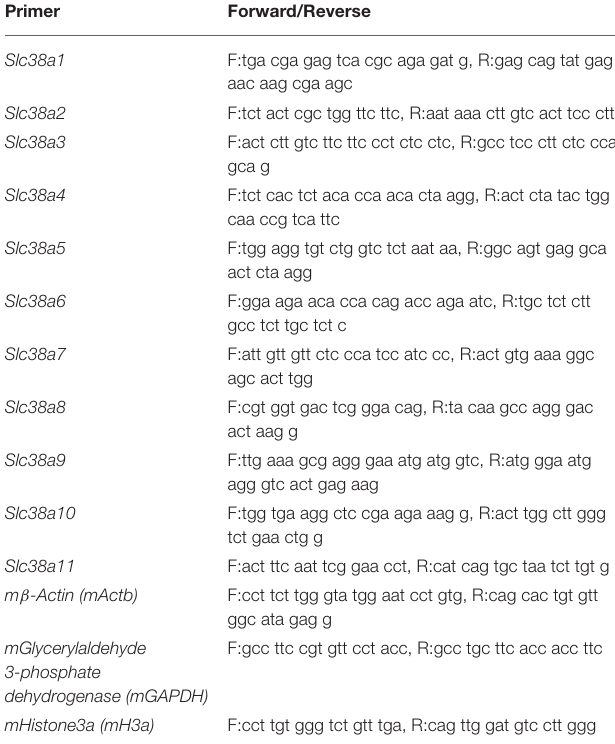
TABLE 1 | Primers used for